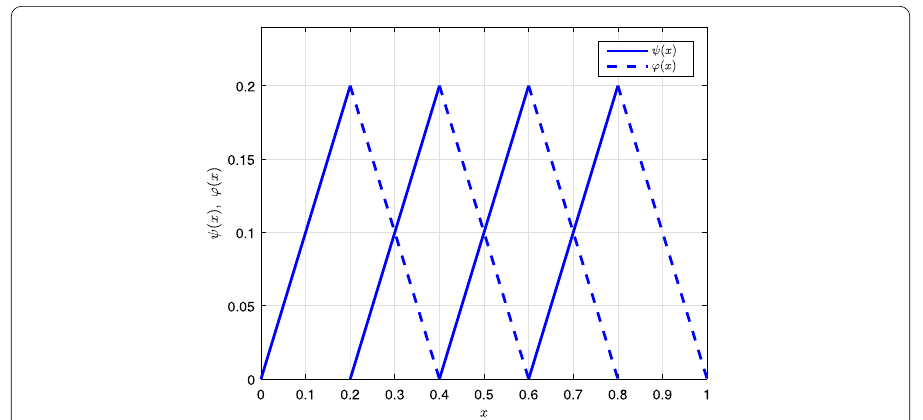
Figure 2 Local Green functions ( κ = 1) Graphs of the local Green functions ψ i (solid line) and ϕ i (dotted line) in the case of κ ( x ) ≡ 1 with a uniform mesh on [0,1] and n =